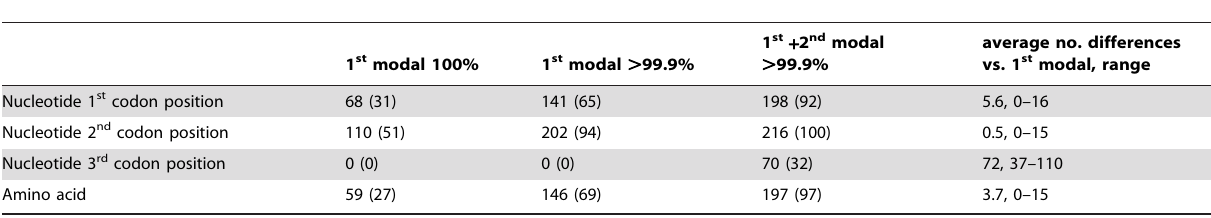
Table 1. Conservation of nucleotide and amino acid positions in avian BARCODEs.